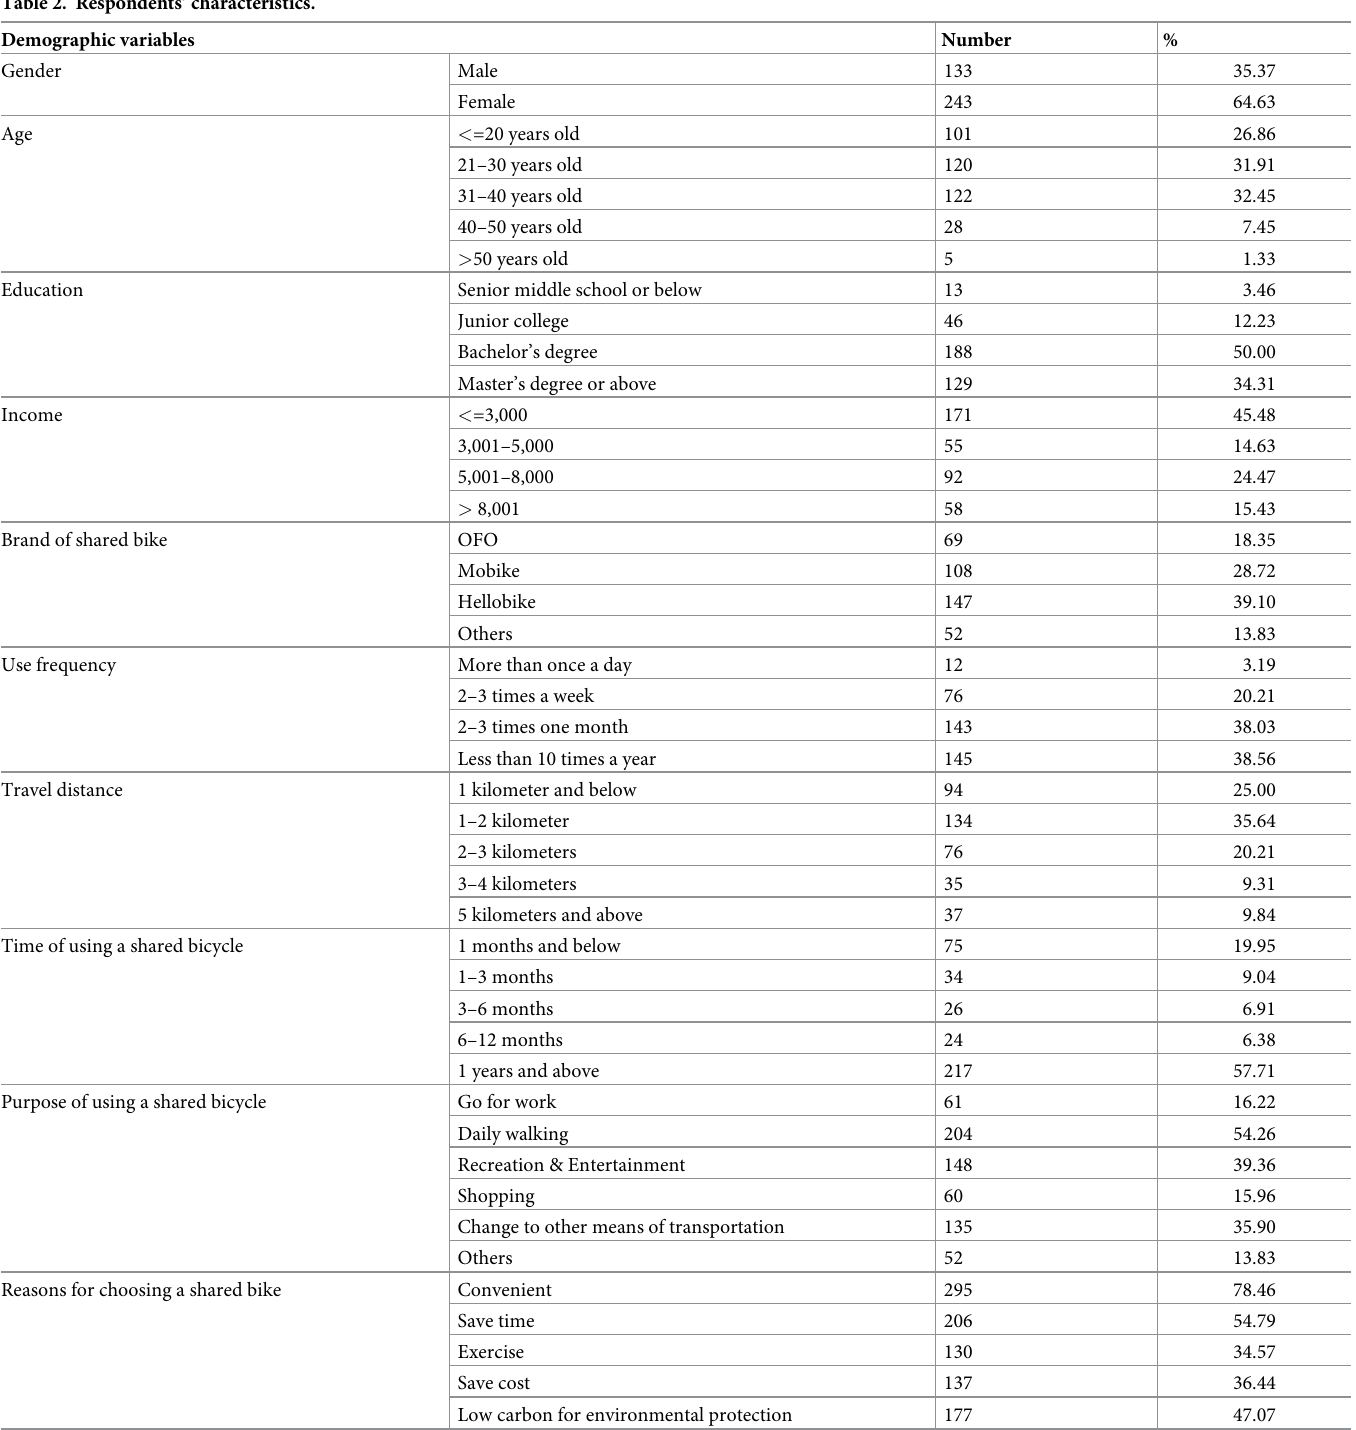
Table 2. Respondents’